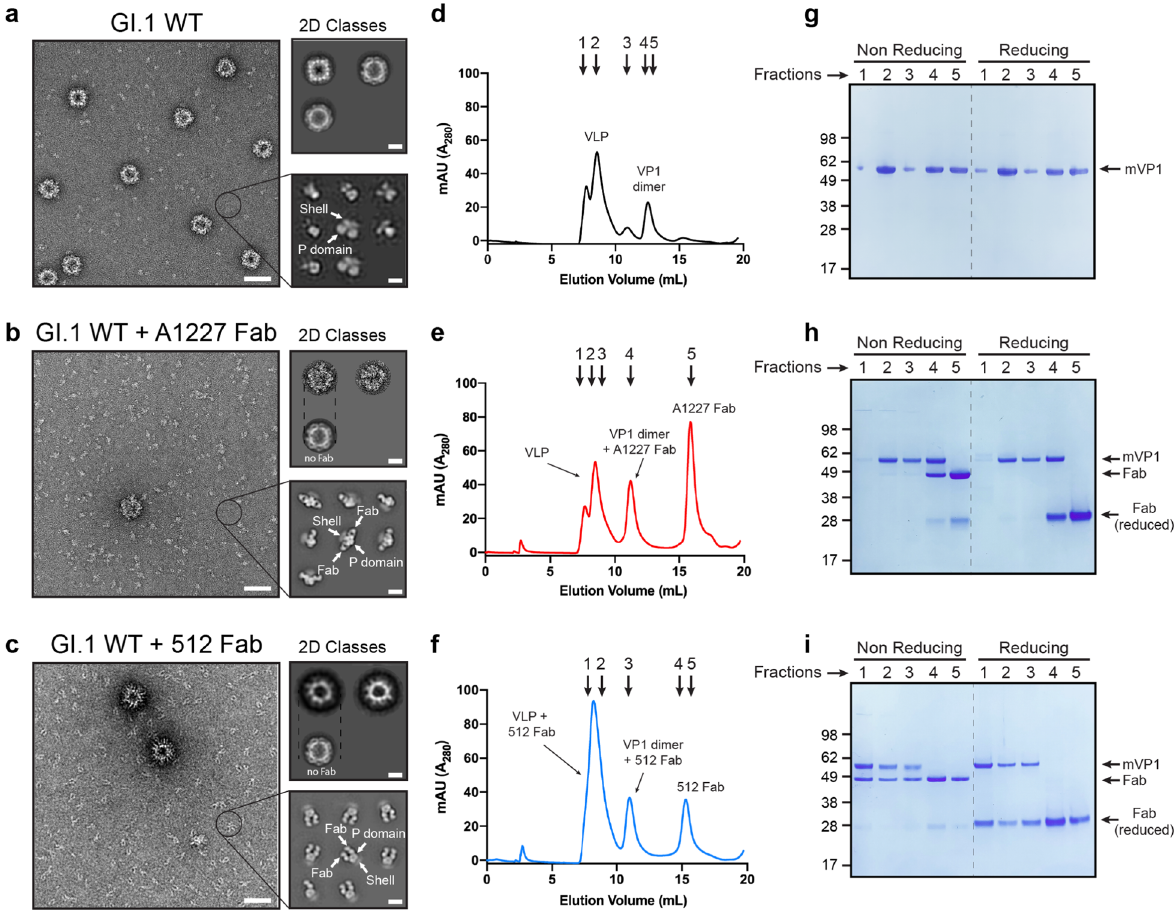
Fig. 1 Dissociation of GI.1 norovirus VLPs leads to exposure of occluded epitopes. a Representative micrograph of negatively stained GI.1 WT VLPs. 2D class averages of small objects are shown in the bottom right corner, and 2D class averages of intact VLPs in the top right corner. Notice the presence of dissociated VP1 dimers and larger oligomers. The shell and P domain are indicated by white arrows. b Representative micrograph of GI.1 WT after incubation with A1227 Fab fragment. 2D class averages of small objects show 2 Fabs bound to each VP1 dimer. Intact particles do not show any A1227 Fab bound. c Representative micrograph of GI.1 WT after incubation with 512 Fab fragment. Class averages show VP1 dimers bound to two Fabs and intact VLPs decorated with a layer of 512 Fabs. d – f Analytical